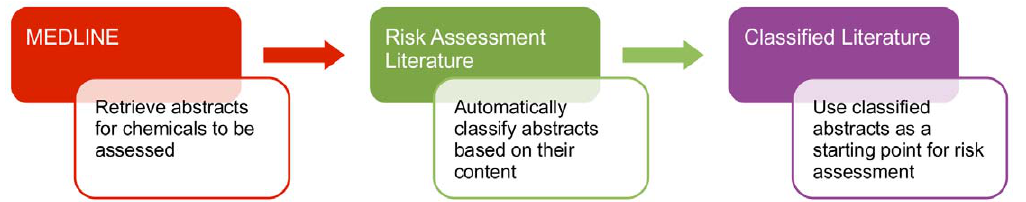
Figure 6. An overview of the CRAB text mining tool.